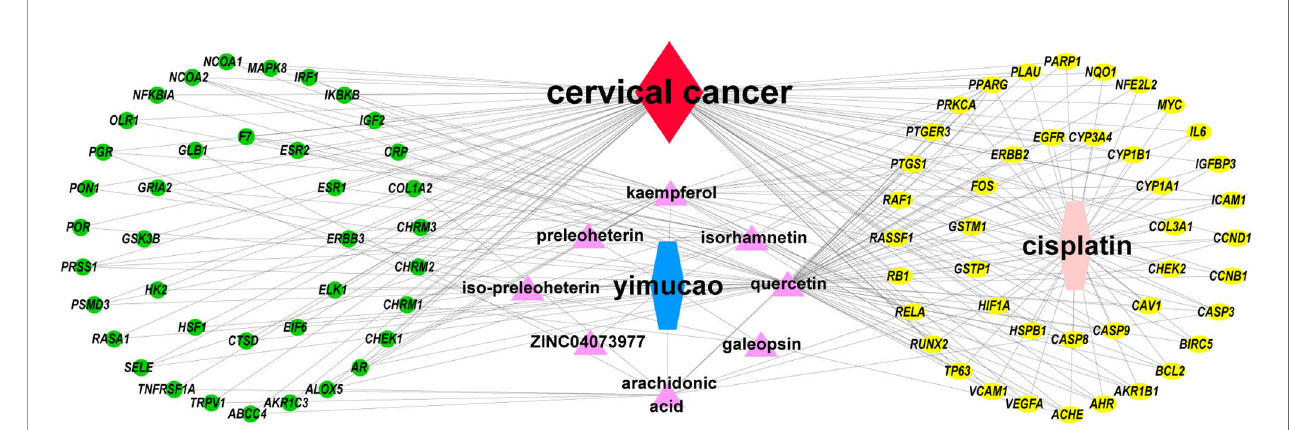
FIGURE 3 | Drug-bioactive compound-disease-target network of combined treatment with Yimucao and cisplatin for cervical cancer. The green circle represents the gene, the yellow circle represents overlapping genes of cisplatin, quercetin, and cervical cancer target genes, and the pink triangle represents compounds of Yimucao. The red diamond indicates cervical cancer. The blue and pink hexagons represent Yimucao and cisplatin, respectively.